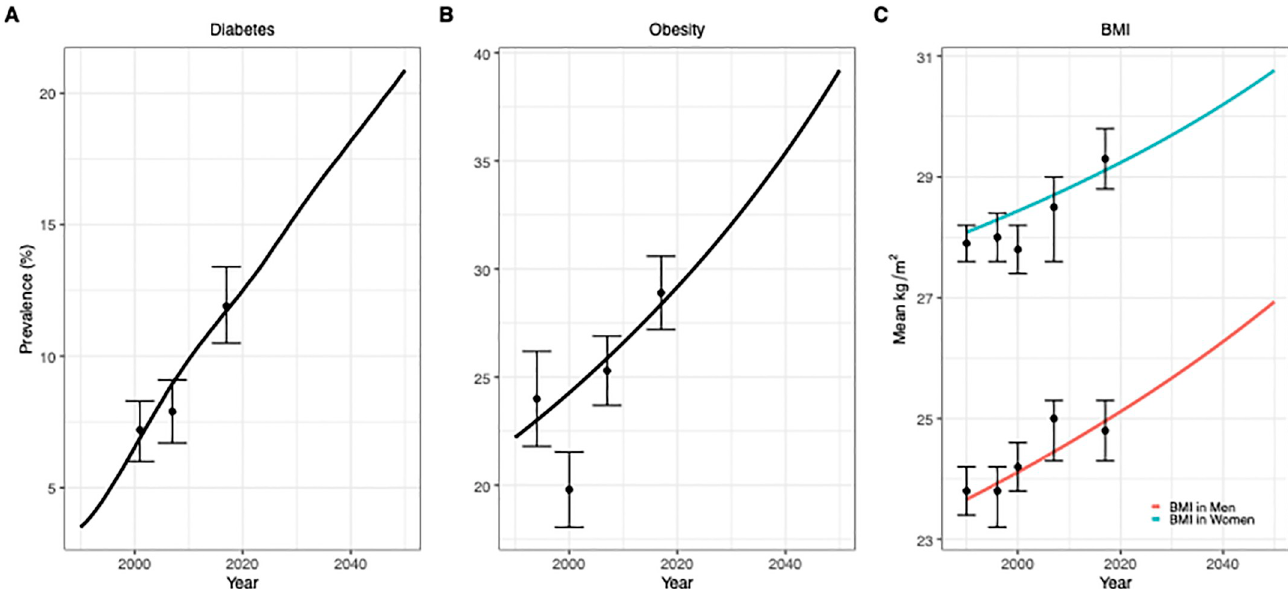
Fig 2. Comparison of modelled outcomes (diabetes prevalence (A), obesity prevalence (B), and body mass index (C)) and projections to 2050 to survey measured estimates in adults (20+ years with 95%CI) from Jamaica(19–22).